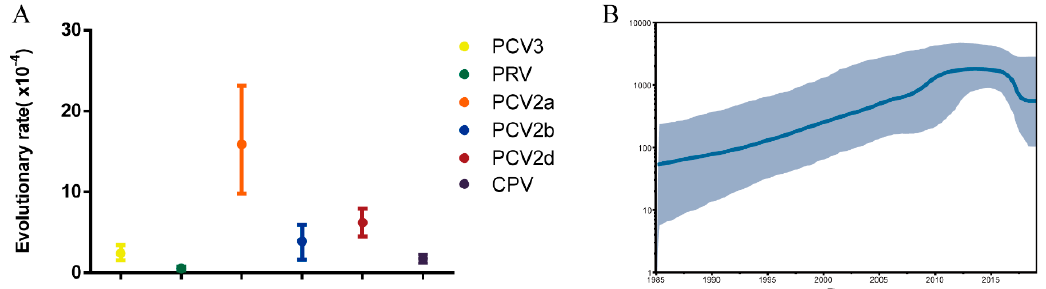
Figure 3. ( A ) Evolutionary rate for the PCV3 Cap gene. The evolutionary rate was estimated using BEAST (v1.8.4) with the GTR + G model and a relaxed lognormal molecular clock. The tree prior was set at coalescent: Bayesian skyline, and total chain length was 1 × 10 8 with sampling every 10,000 steps. ( B ) Bayesian skyline plot for the PCV3 Cap gene. The mean genetic diversity through time ( N e t ) for the PCV3 ORF2 gene is shown by the black boldface line, while the 95% highest probability density (HPD) of N e t is plotted on the y -axis (grey region).